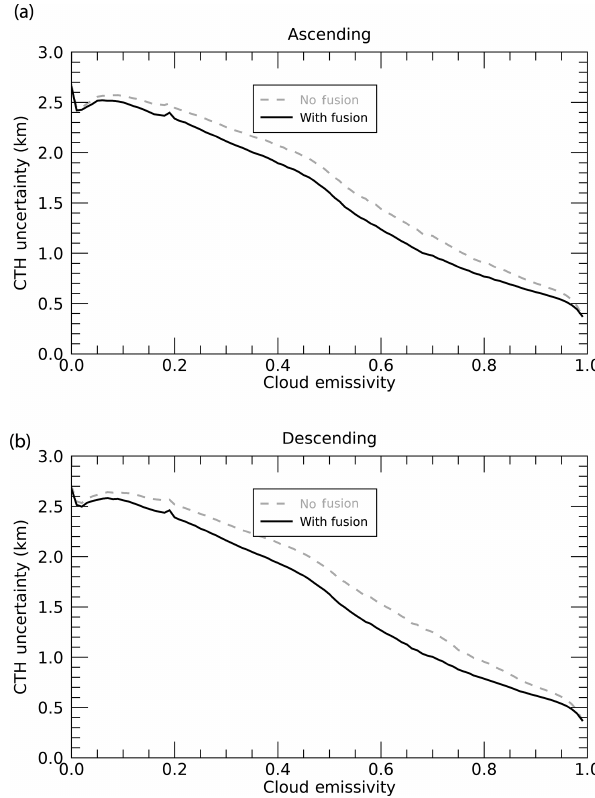
Figure 10. Ice cloud top height uncertainty as a function of cloud emissivity for the S-NPP VIIRS computed from 2 weeks of global level-2b data in